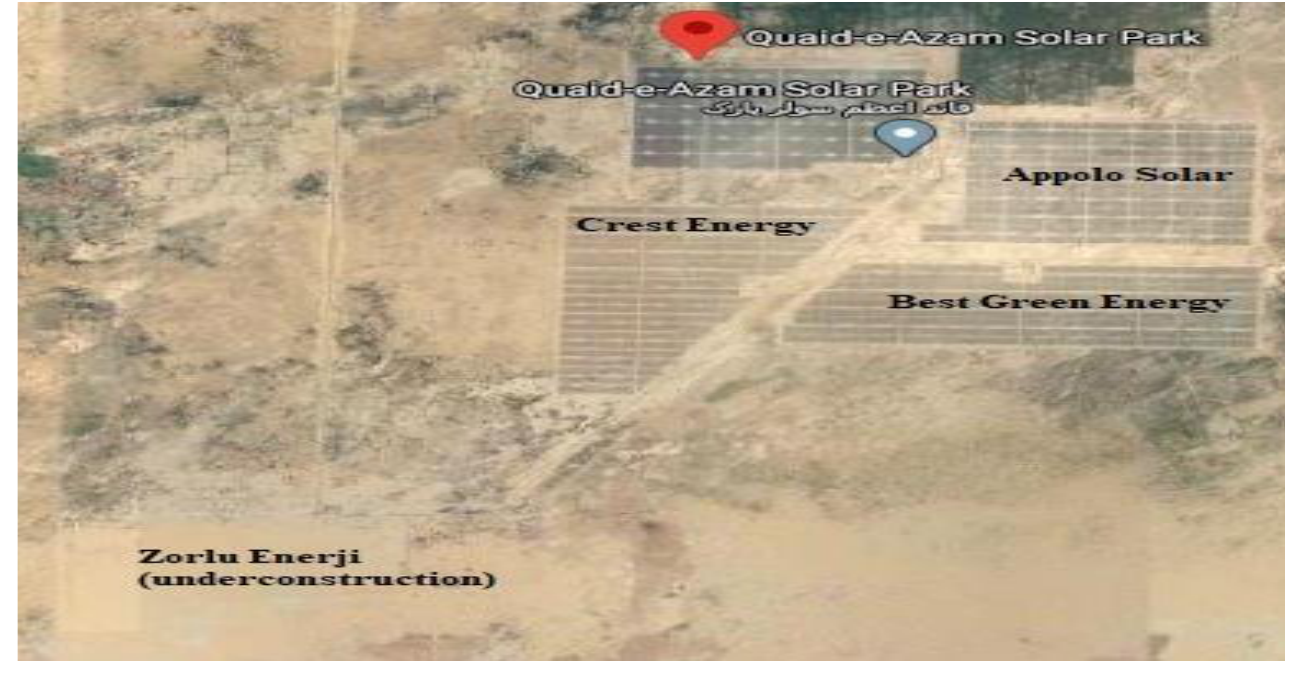
Fig. 2. Location of 100MW solar power plants in Bahawalpur,